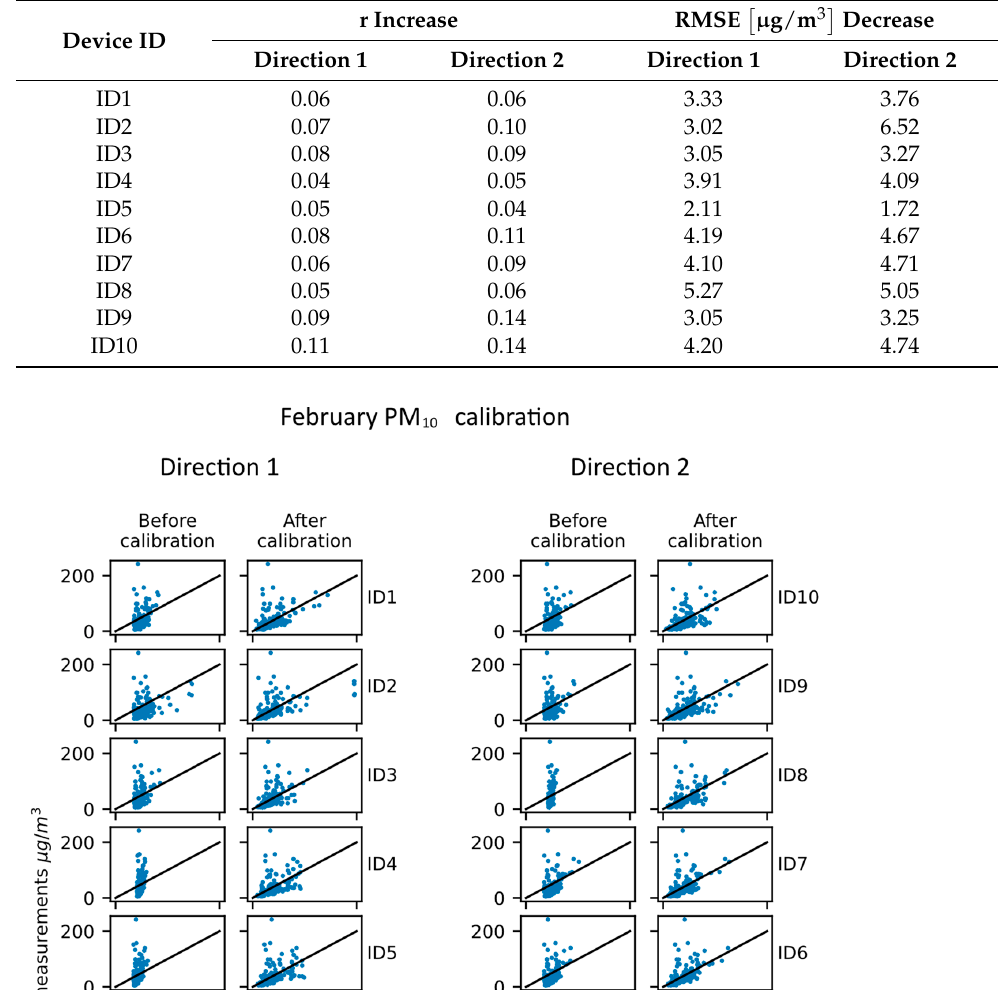
Table 3. Results of the PM 10 calibration propagation in February, improvements in comparison to the parameters before calibration.